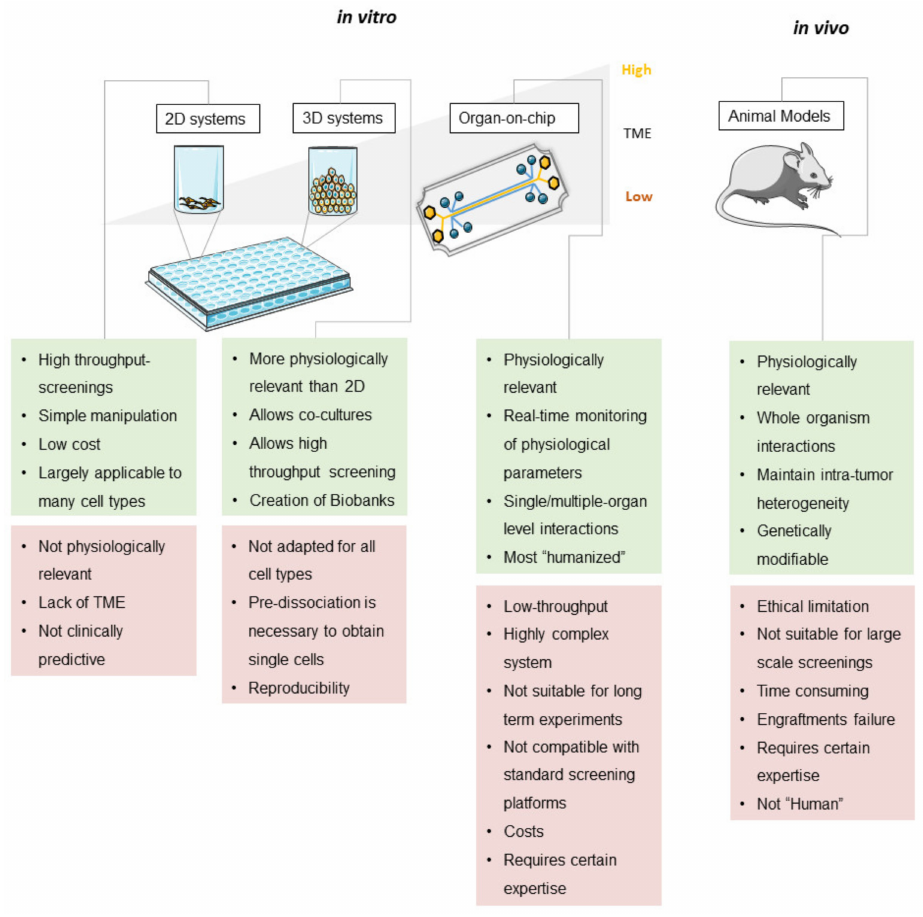
Figure 2. Advantages and weakness of CRC patient-derived models in preclinical